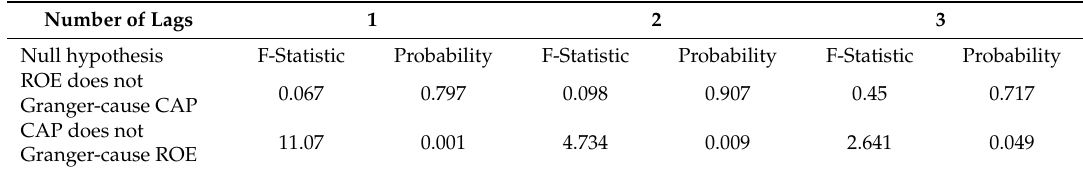
Table 1. Pairwise Granger-causality